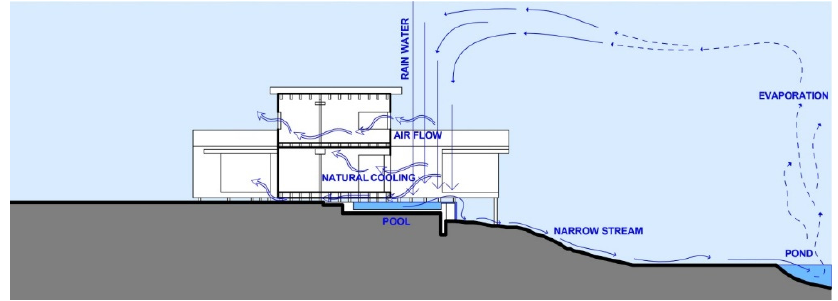
Figure 5. Karuizawa summer house, section, and natural ventilation. It anticipates eco-friendly, sus- tainable houses. sustainable